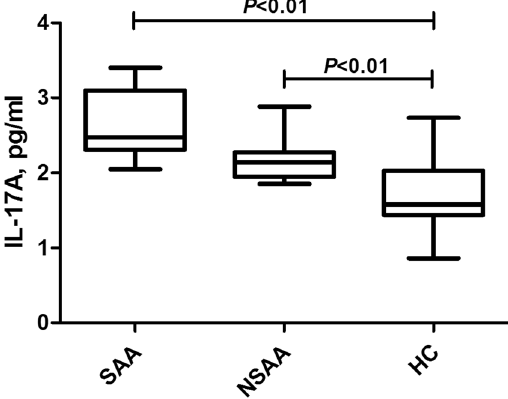
Figure 5. Plasma concentrations of IL-17A in patients with aplastic anaemia and the healthy controls. SAA: severe aplastic anaemia; NSAA: non-severe aplastic anaemia; HC: healthy